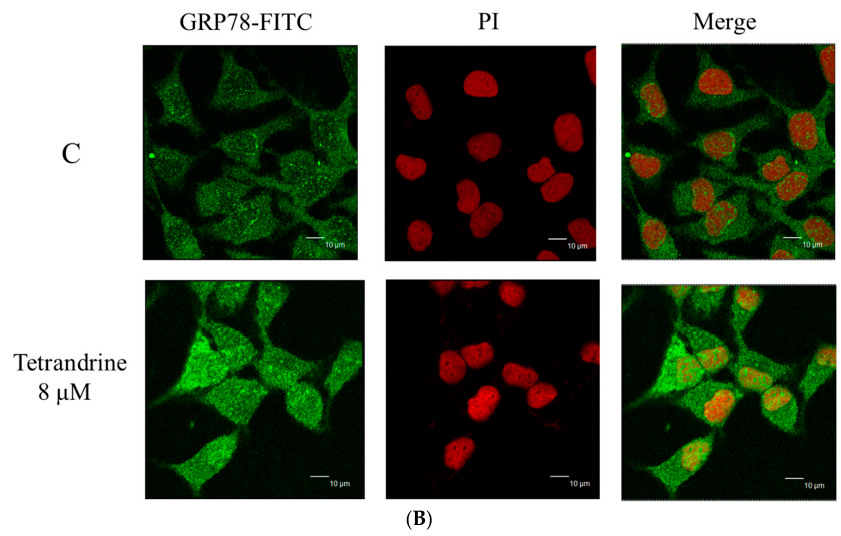
Figure 6. TET affects the translocation of apoptotic associated proteins in NPC-TW 076 cells. Cells were treated with 8 μ M of TET for 24 h and cells were stained by anti- GADD153 ( A ) and GRP78 ( B ) and were stained with secondary antibody (FITC-conjugated goat anti-mouse IgG (green fluorescence) and PI (nuclear staining; red fluorescence) and followed by being examined and photographed by a Leica TCS SP2 confocal laser microscopic systems as described in Materials and Methods.